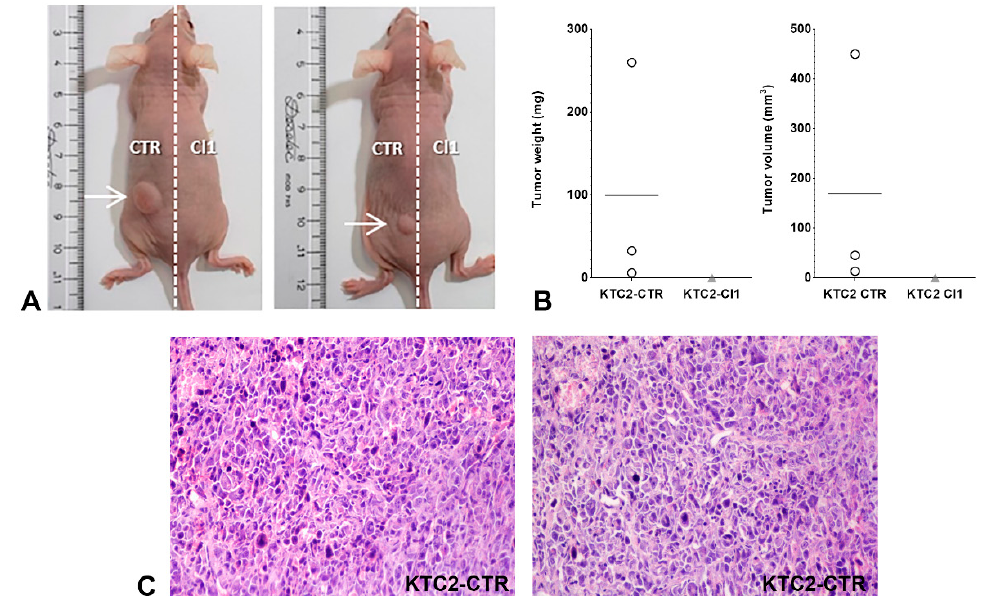
Figure 6. ( A ) Representative image of animals injected with KTC2-CTR cells (in the left flank) and KTC2-Cl1 cells (in the right flank). ( B ) Tumor weight and volume of KTC2-CTR cells compared to KTC2-Cl1 cells (no tumor) after animal euthanasia in the endpoint. n = 3 animals. KTC2-CTR; (cid:78) KTC2-Cl1. ( C ) Histological section of KTC2-CTR tumor stained with H&E. Magnification: 200×.